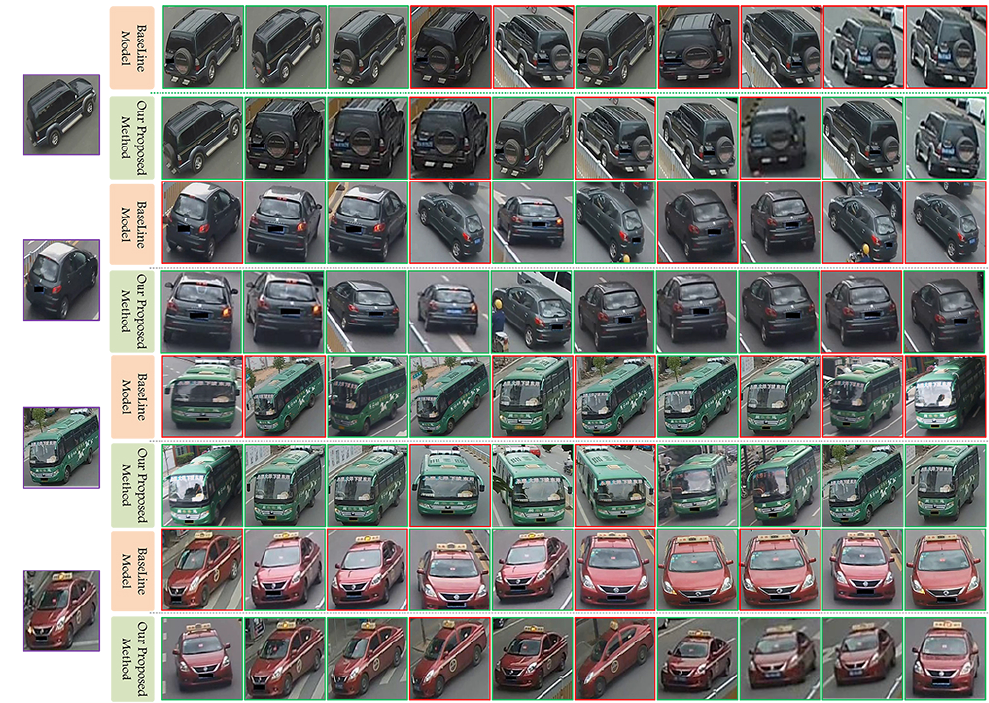
Figure 9. Parts of visual object Re-ID results on the VeRi-776 using the baseline module and the HP-SET-Attn configuration of the proposed AAD-CPGE